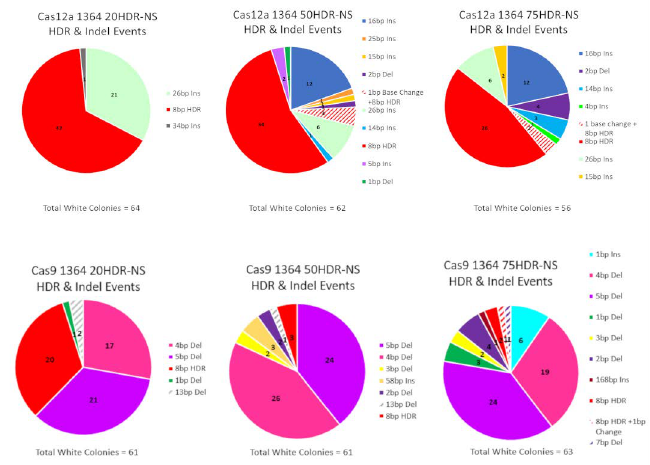
Figure 5. Frequency of HDR and Indel events in CRISPR / Cas12a and CRISPR / Cas9 reactions. Each pie chart represents a reaction condition utilizing CRISPR / Cas12a or CRISPR / Cas9 in combination with the 20, 50, or 75 base homology arm ODN and the triplicate experiments done within each nuclease. The total number of events (HDR or Indels) and the frequency of those events are illustrated by di ff erent colors. A precise integration of the eight base NOTI site is depicted in red and the remaining colors depict various types of